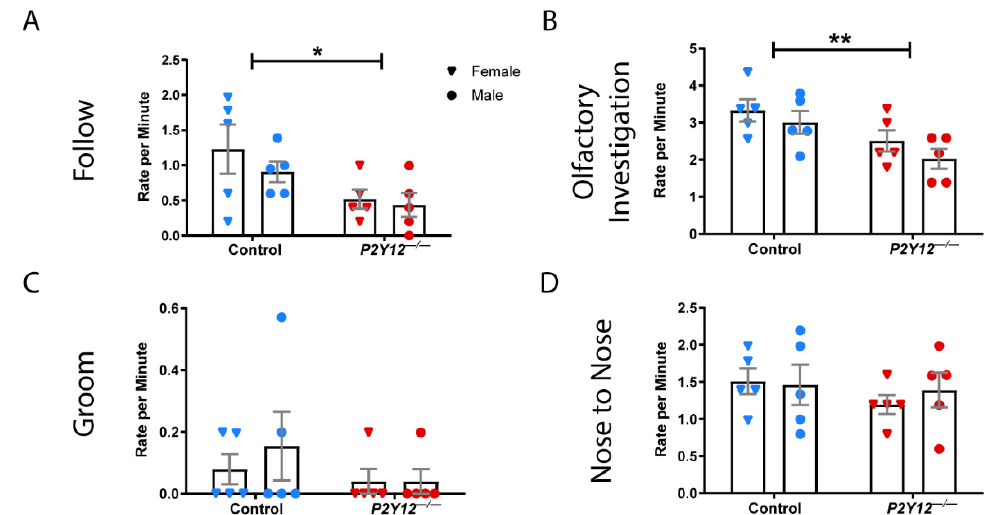
Figure 7. P2Y12 —/— mice exhibit a subset of altered social behaviors. P2Y12 —/— mice exhibited a decreased rate of following ( A ) and olfactory investigation ( B ) behaviors but not allogrooming ( C ) or nose-to-nose investigation ( D ). ( A )–( D ): two-way ANOVA, Sidak post hoc, * p < 0.05, ** p < 0.01; n = 20 mice per genotype (10 males, 10 females); graph shows the mean +/ − SEM.